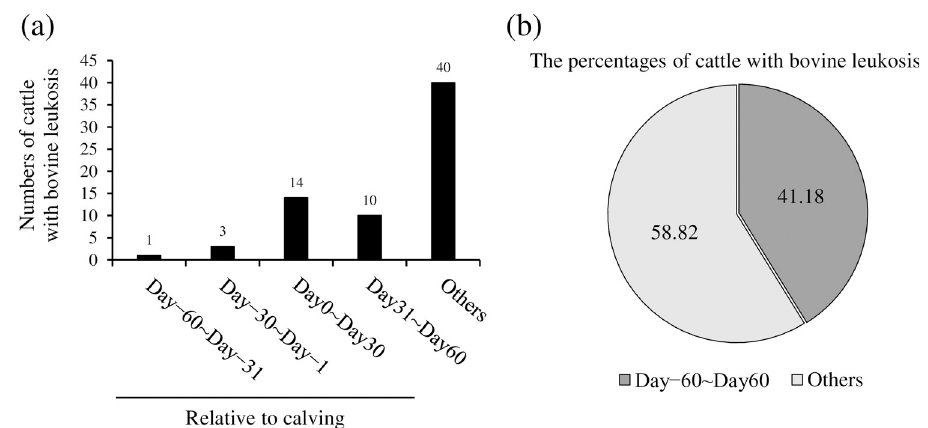
Fig 1. The relationship between the onset of bovine leukosis and parturition. The numbers (a) and the percentages (b) of cattle diagnosed as bovine leukosis ( n = 67). The day of delivery was considered as day 0.